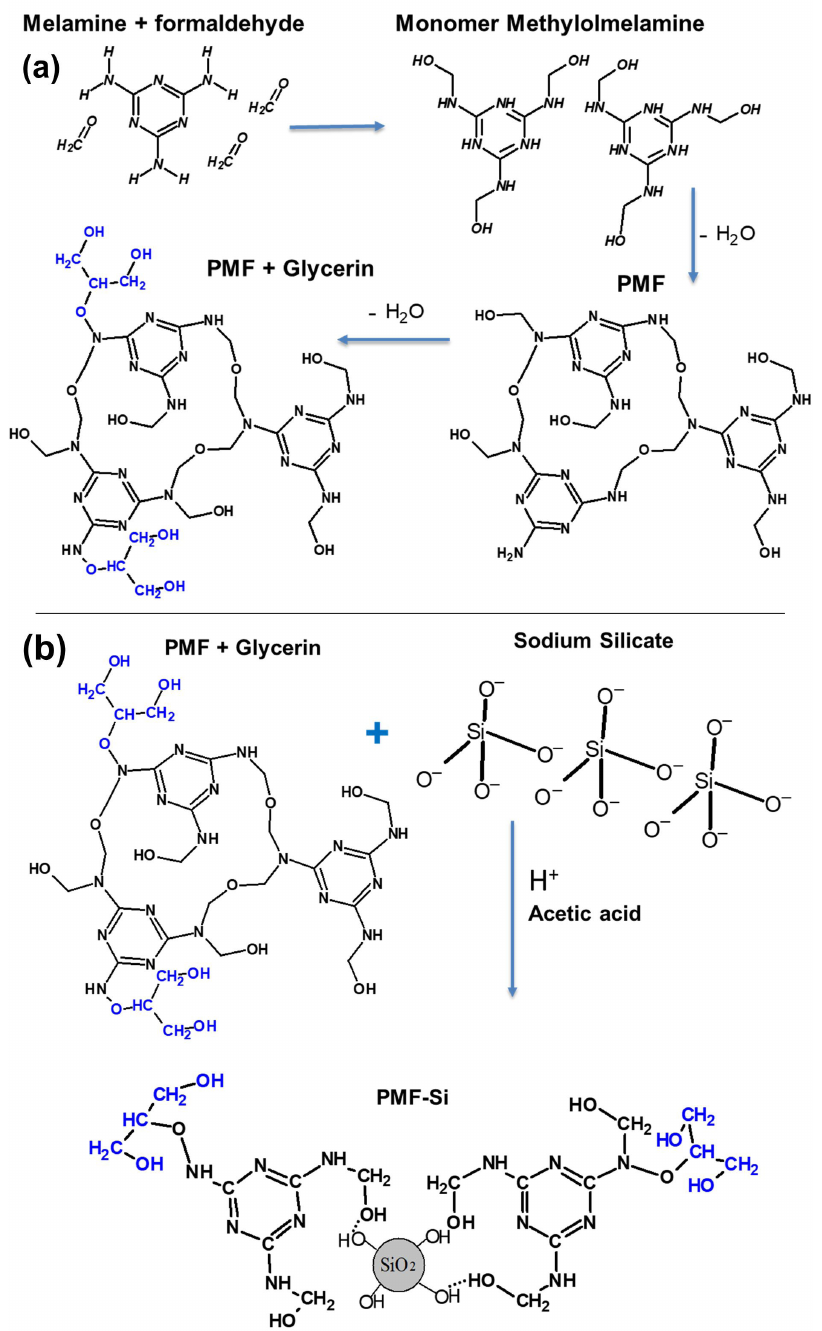
Figure 1. (a) Simplified depiction of PMF synthesis and incorporation of glycerin. (b) Preparation of the PMF-Si